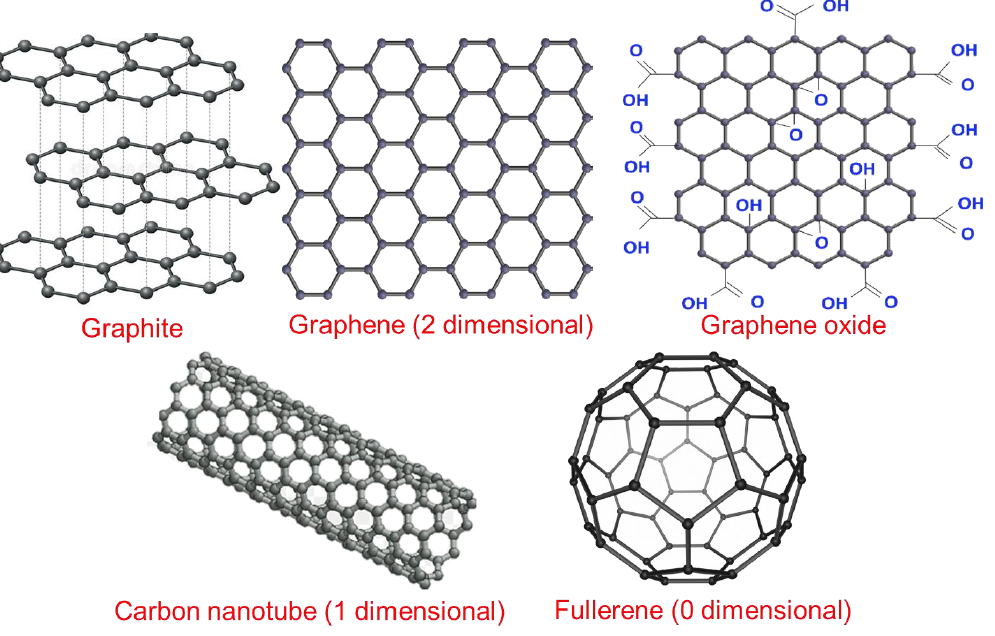
Figure 3. Various carbon nanofillers in shape memory